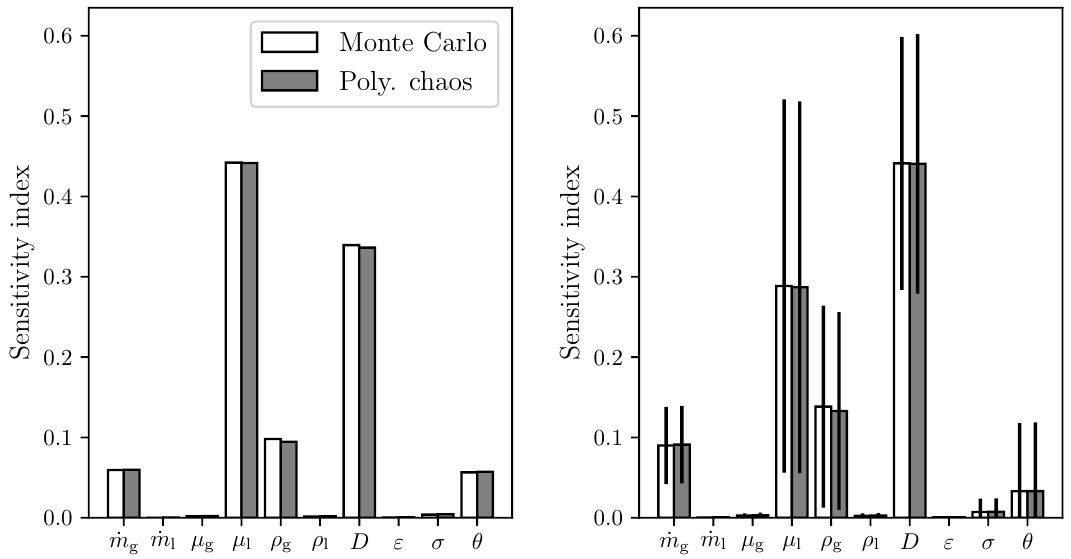
Figure 4. Holdup sensitivity estimates averaged over 233 experiments. ( Left ) Weighted by the variance in each experiment. ( Right ) Plain averages with standard error